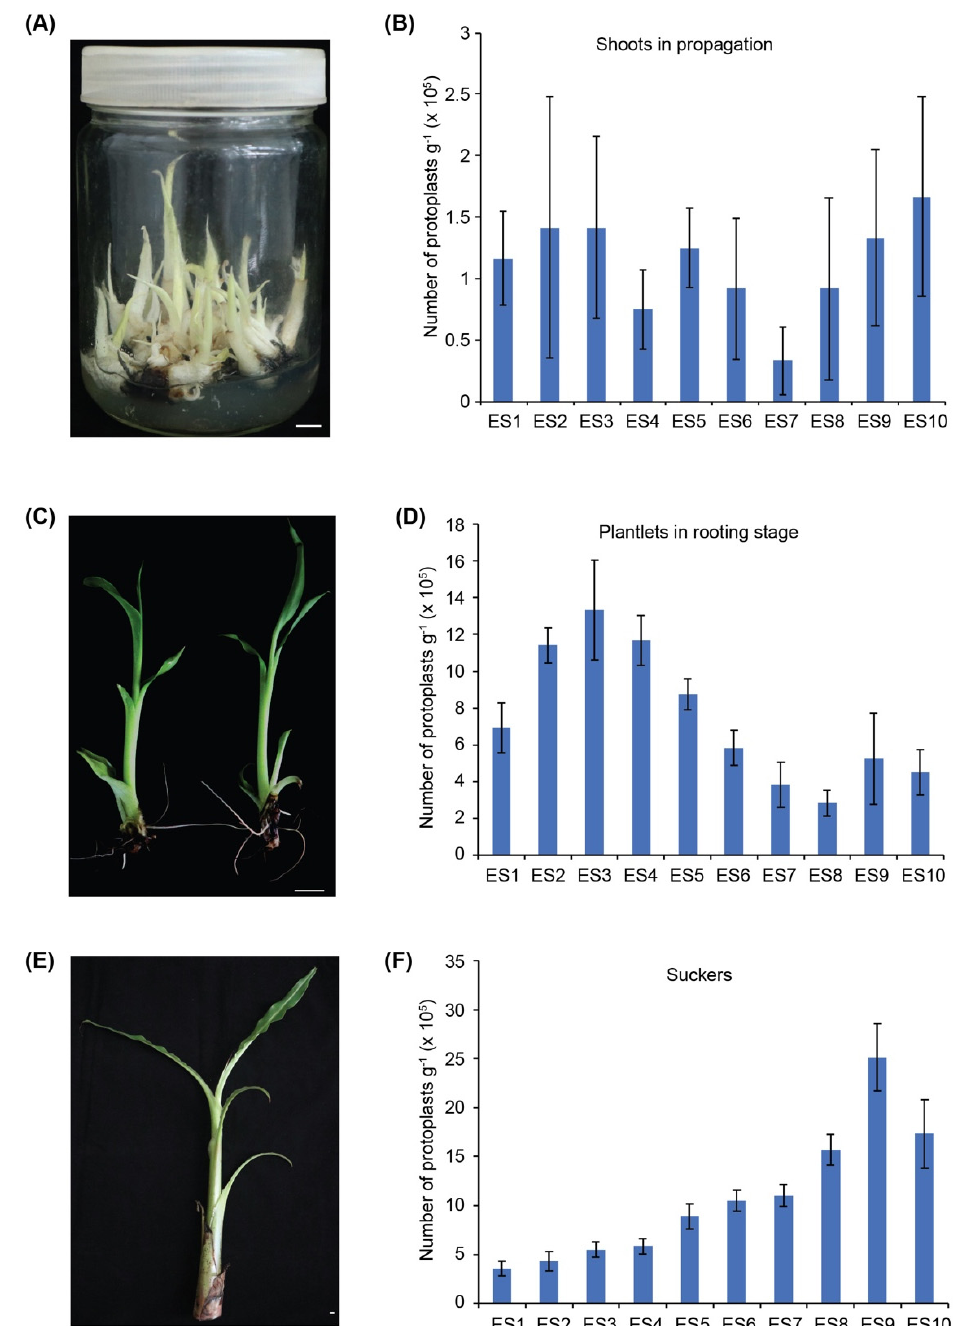
Figure 1. Yields of the protoplasts from different tissues of banana. ( A , C , E ) Banana shoots in propagation ( A ), plantlets in rooting stage ( C ), and suckers ( E ) used for protoplasts isolation. Bar = 1 cm. ( B , D , F ) The yields of protoplasts isolated from ( A , C , E ), respectively, after 6 h digestion in different enzyme solutions (ES1 to ES10, Table 1). Y-axes represent the number of protoplasts per gram fresh weight ± SD ( n = 4). The different letters indicate statistically significant differences ( p < 0.05).